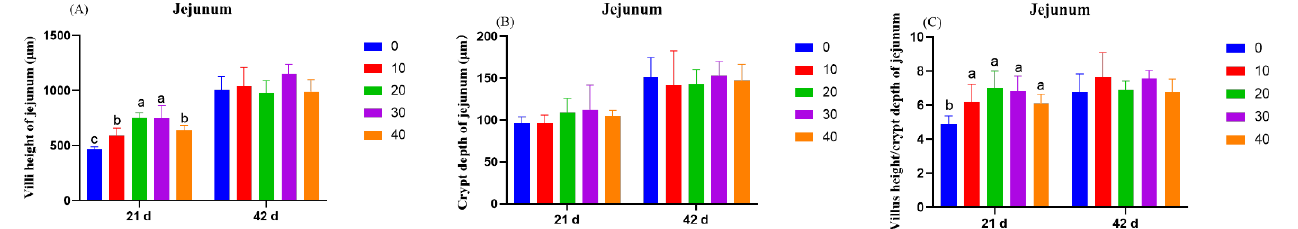
Figure 1. Effects of dietary 1,8-cineole supplementation on jejunum morphology of broiler chickens: ( A ) villi height; ( B ) crypt depth; ( C ) villi height/crypt depth. a,b,c Means within a row with different superscripts are significantly different ( p < 0.05).